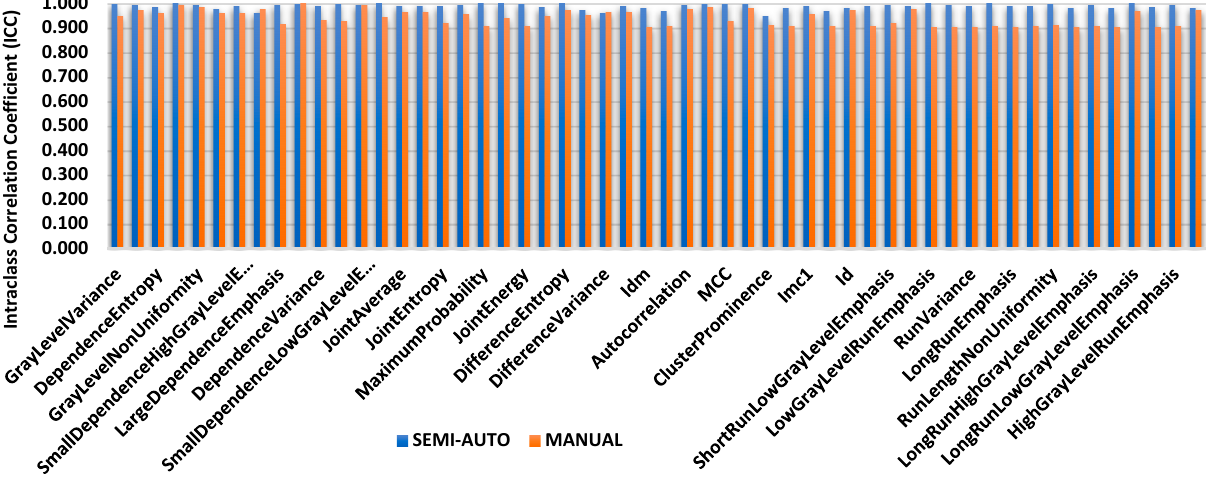
Figure 5. Intra-class correlation coefficient (ICC) comparisons for textural features.